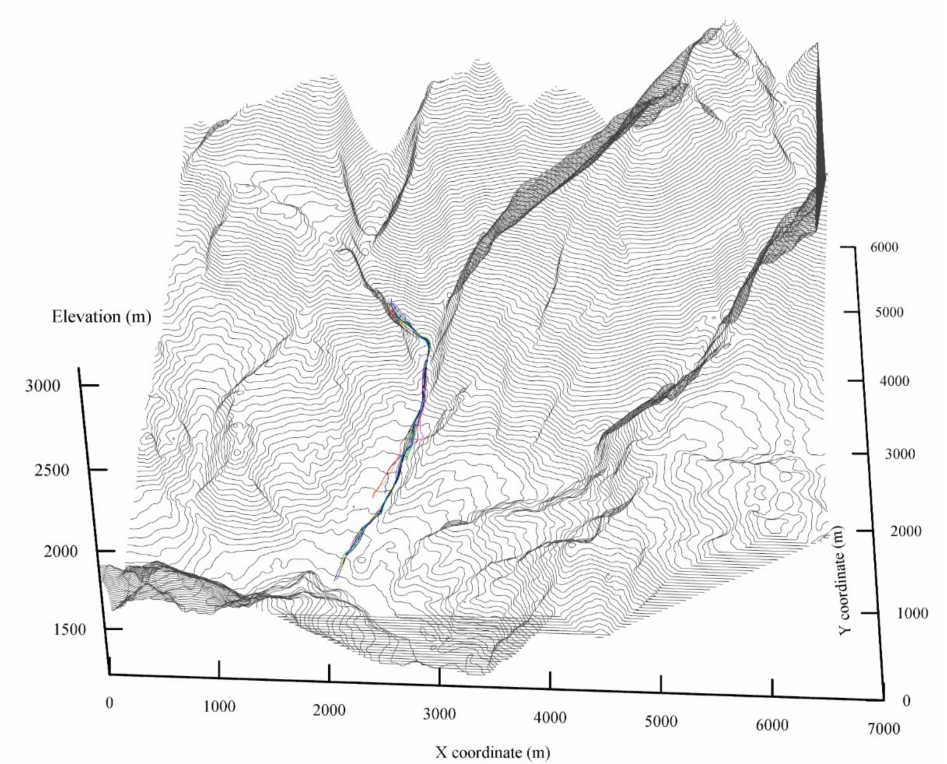
Figure 13. Movement tracks of the boulders under different simulation